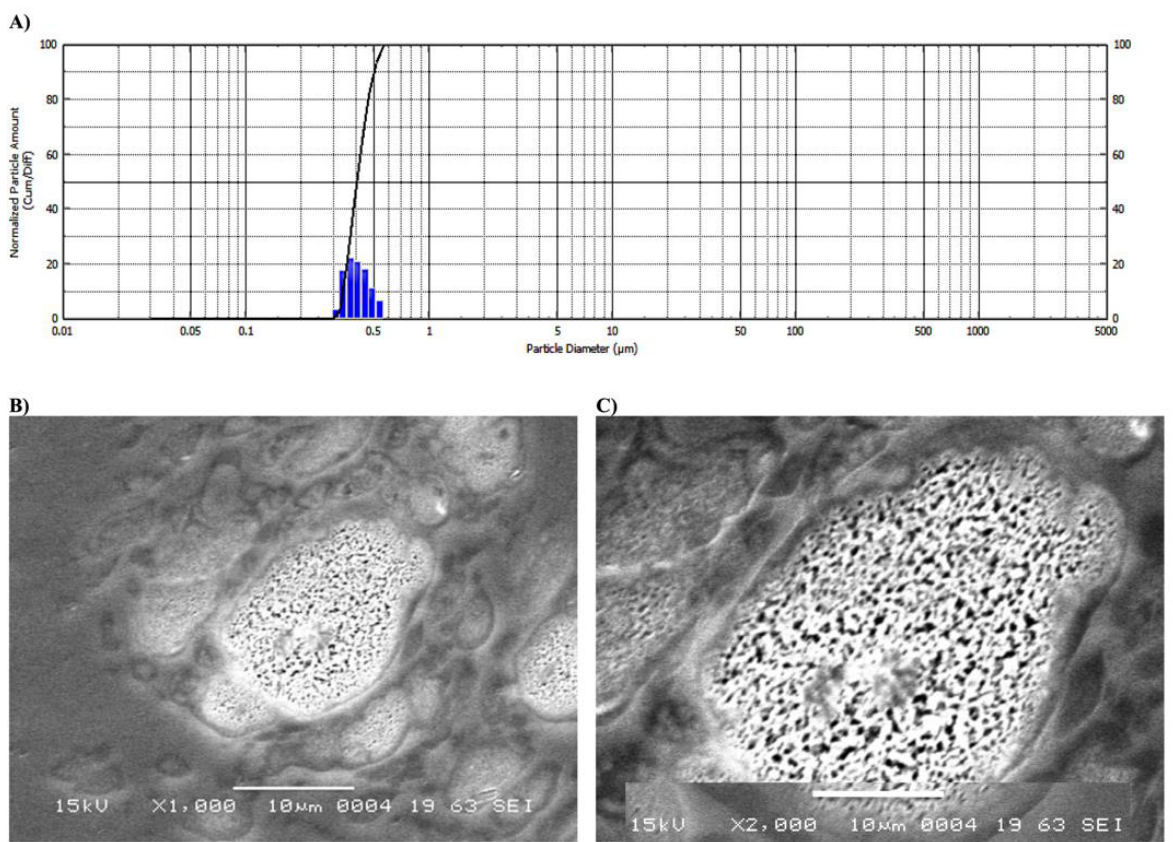
Figure 2. Characterization of the formulated γ -lactone-MC-NPs: ( A ) Particle size distribution, ( B ) Images taken with SEM at ×1000, and ( C ) Images taken with SEM at ×2000.